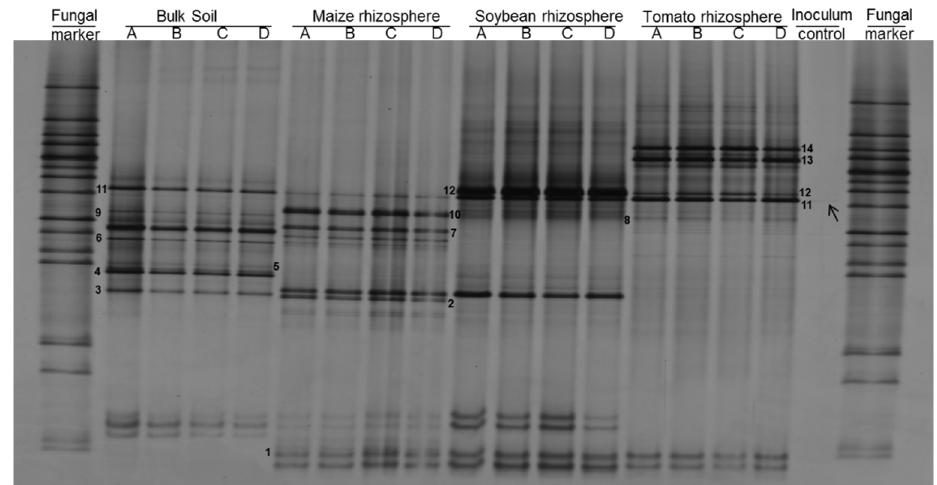
Figure 1. Denaturing gradient gelelectrophoresis ( DGGE) profiles of fungal internal transcribed spacer (ITS) fragments amplified from DNA of Pratylenchus penetrans incubated in suspensions of bulk soil and rhizosphere soils (Experiment 1). Letters A, B, C, and D represent biological replicates. Surface-sterilized nematodes prior to incubation are referred to as inoculum control. Numbers 1–14 represent the bands that were taxonomically assigned by DNA sequencing and that showed specificity of fungal species in their attachment to P. penetrans .